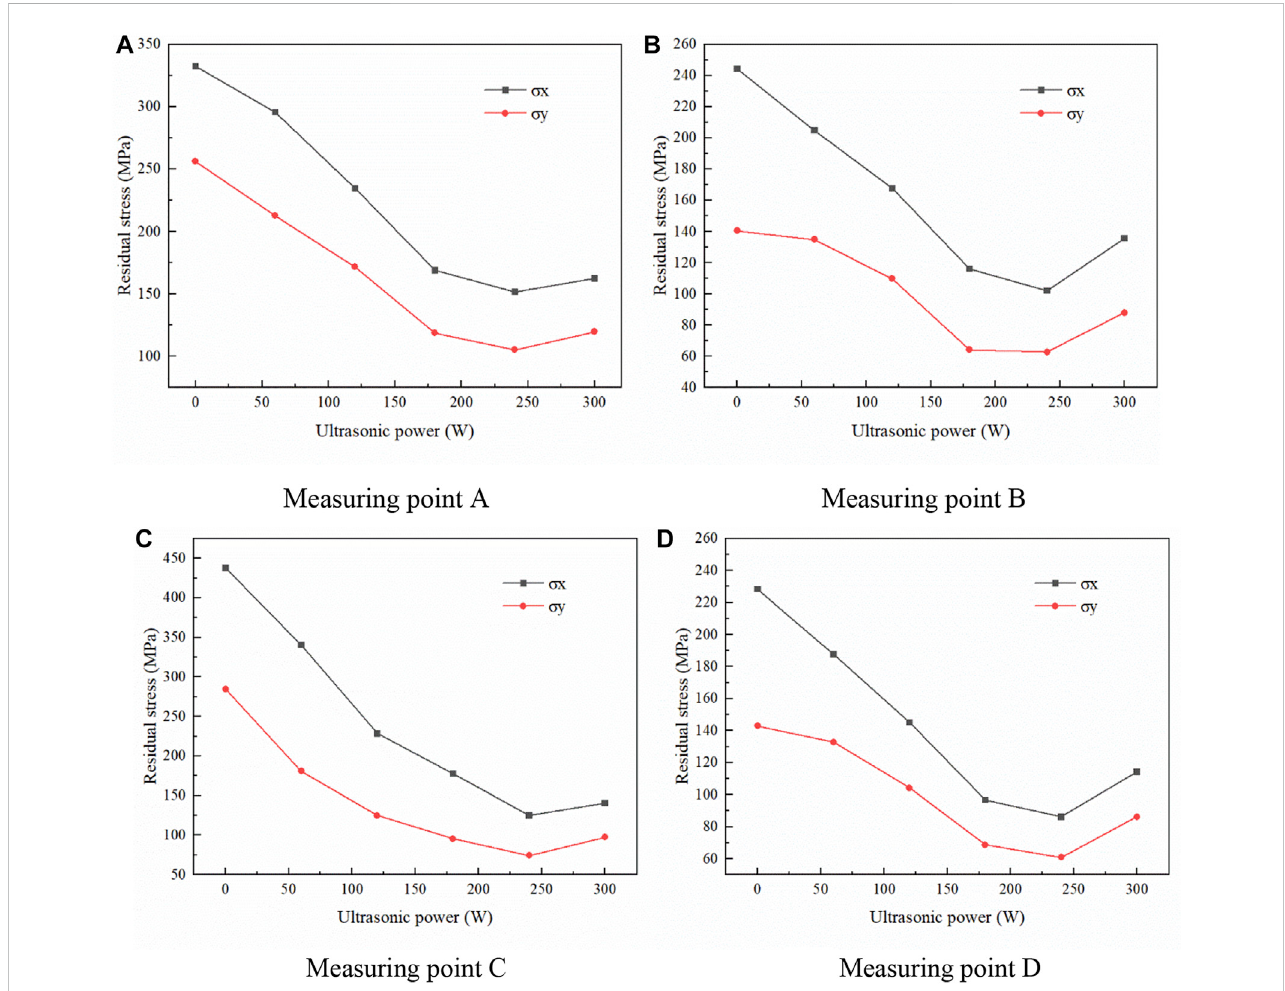
FIGURE 5 Effectofultrasonicpoweronresidualstressateachpoint[ (A) :MeasuringpointA; (B) :MeasuringpointB; (C) :Measuringpoint C; (D) :MeasuringpointD].